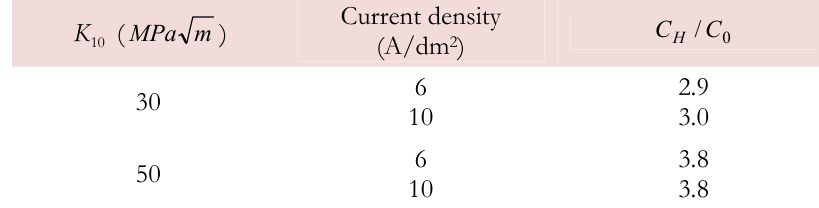
Table 2: The effect of hydrogen charging conditions on the hydrogen distribution ahead of the crack tip on crack extension line. The distribution of hydrogen ahead of the crack tip was measured by the same procedure as for the specimens after the fatigue test [12]. The values of the ratio of the maximum local concentration volume